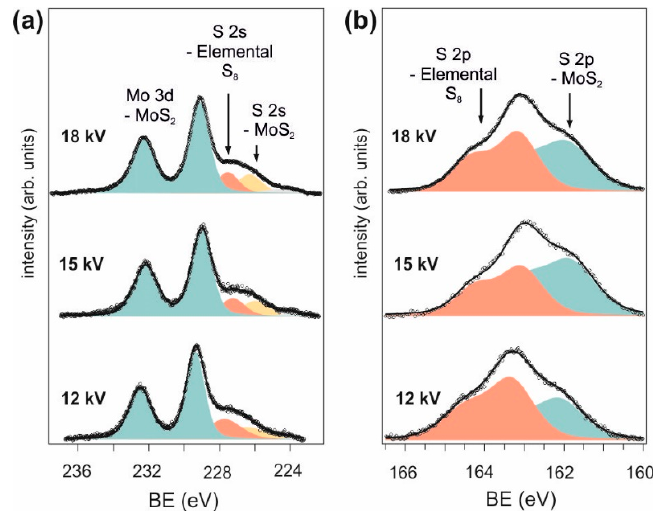
Figure 3. Fitted ( a ) Mo 3d–S 2s and ( b ) S 2p core level spectra of IJD-MoS2 as-deposited with different